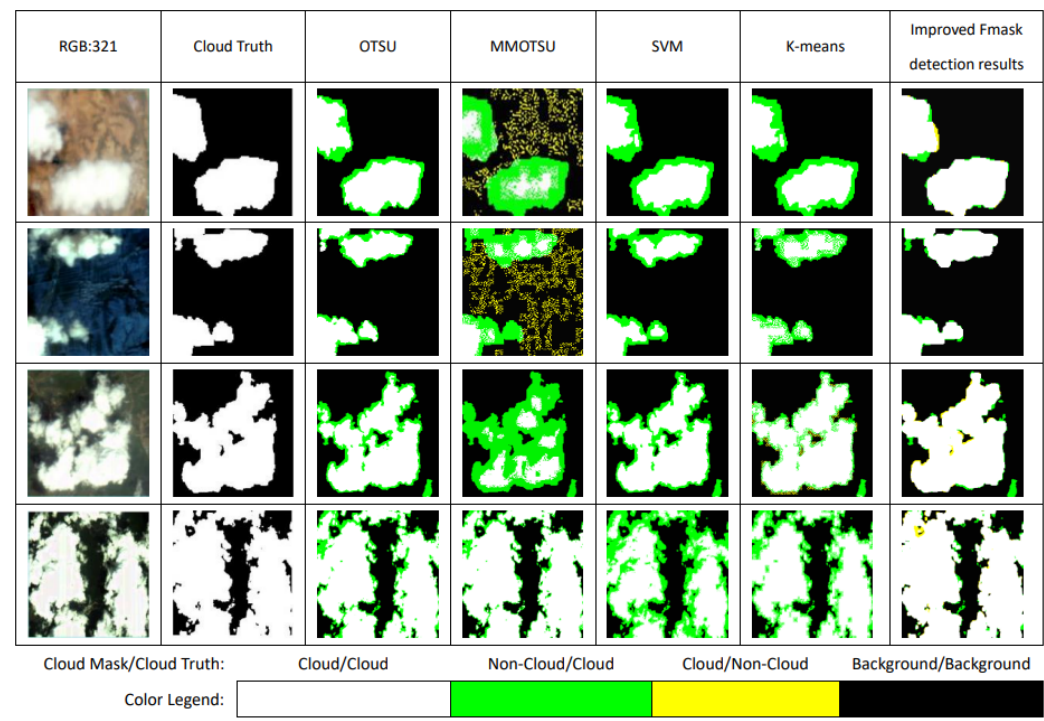
Figure 11. Comparison of the results of different cloud detection methods for thin clouds attached to the edge of thick clouds.Therefore, the improved Fmask cloud detection algorithm has a better recognition effect on thin clouds attached to the edge of thick clouds and reduces the commission errors of clouds. As shown in the rightmost column of Figure 11, the green color is significantly reduced, improving the overall accuracy of cloud detection.